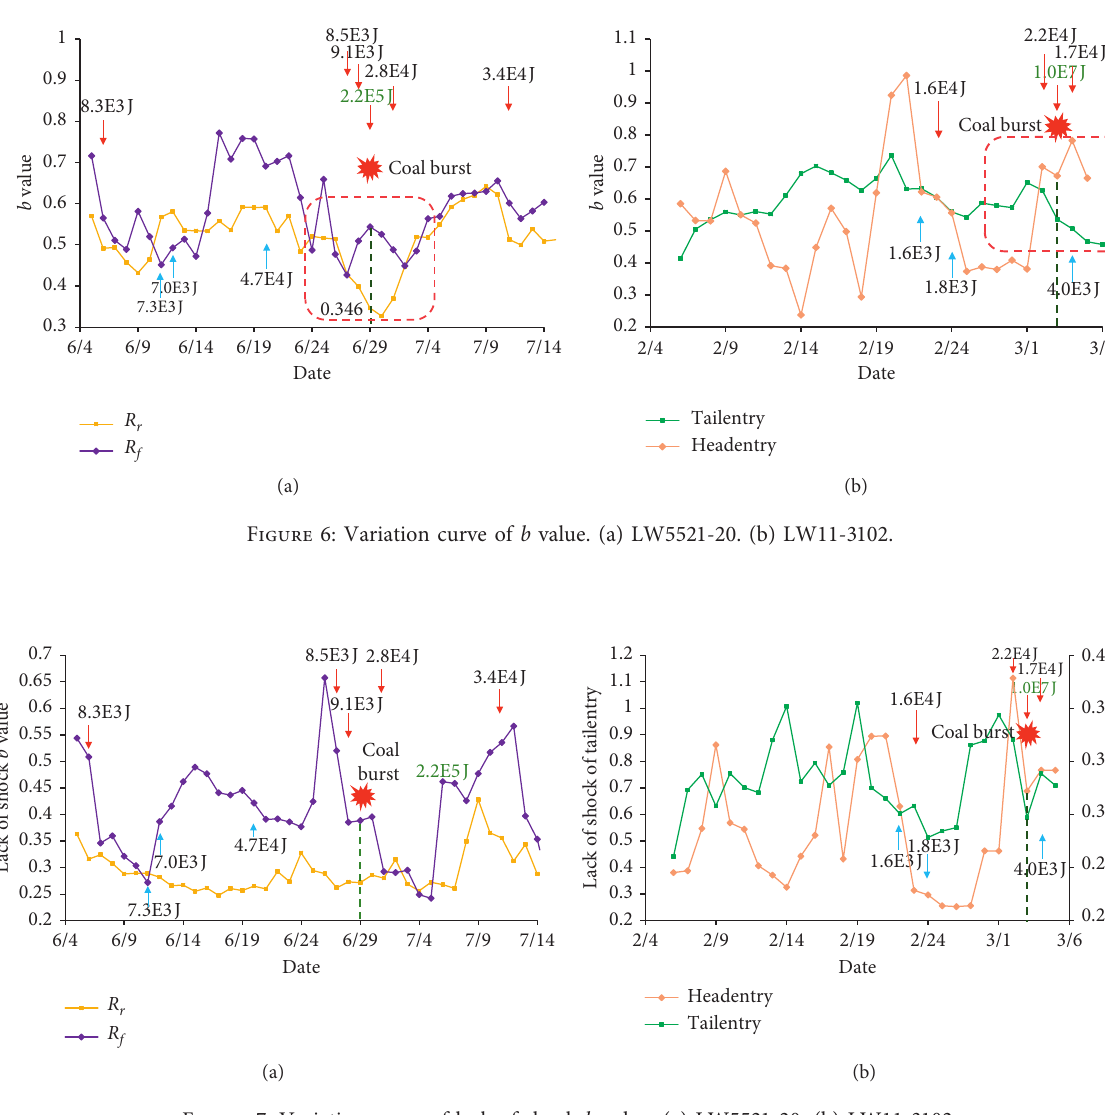
Figure 7: Variation curve of lack of shock b value. (a) LW5521-20. (b) LW11-3102.